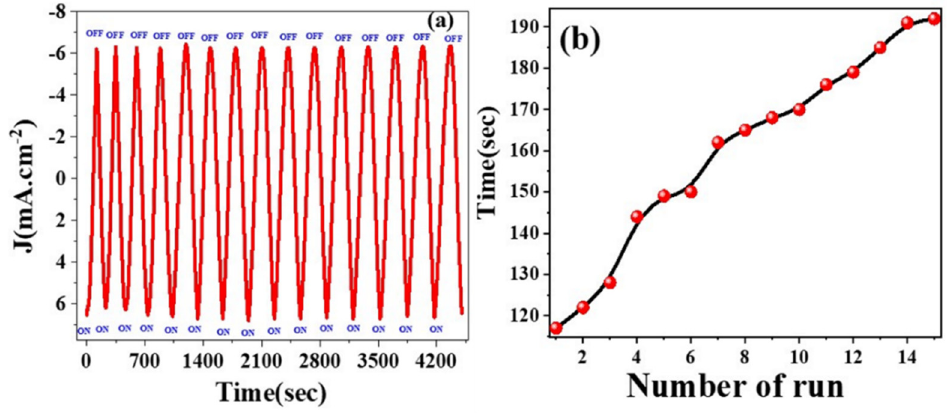
Figure 7. ( a ) Photocurrent intensity for of 3.0% Ni-doped SnO 2 :Ir photocathode under successive on/off illumination cycles and ( b ) time versus number of runs, measured in 0.5M HCl electrolyte under a bias potential of − 0.53 V.